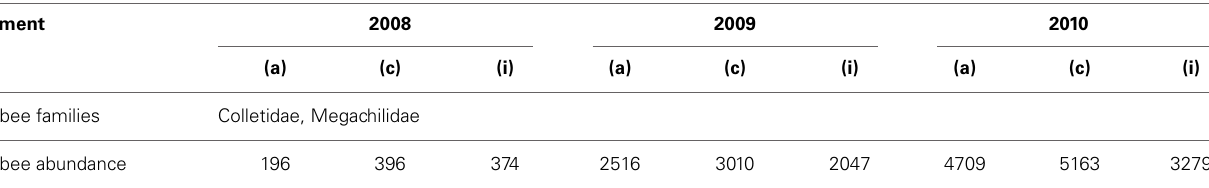
Table 1 | Insect families and overall abundance of functional groups expressed as number of brood cells summed over the three treatments “adjacent” (a), “connected” (c), and “isolated” (i) over the three years